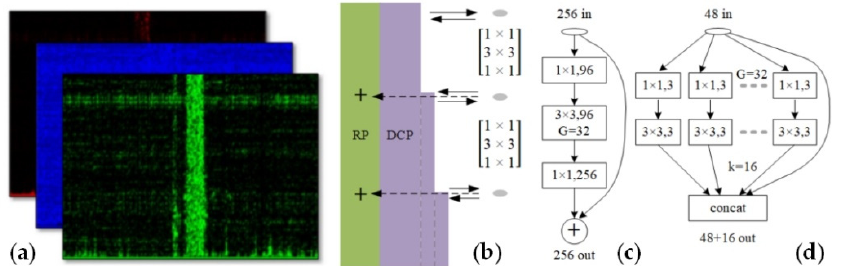
Figure 23. ( a ) The three-channel data sample; ( b ) The architecture of DPN; ( c ) Residual path and ( d ) densely connected path. Reproduced with permission from our previous paper [3], published by Optical Society of America, 2019.